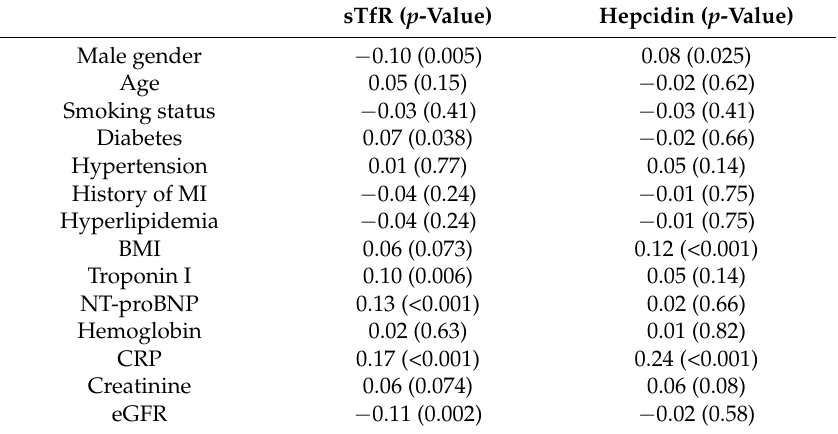
Table 2. Spearman rank correlation coefficients.